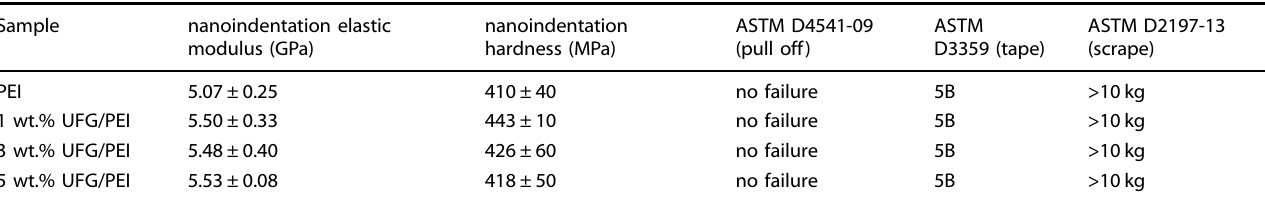
Table 1. Mechanical Testing and Adhesion Data for PEI and UFG/PEI Coatings on AA 7075.